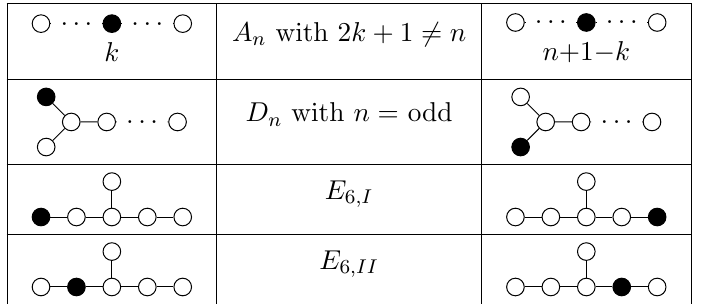
Table 1 . List of dual marked Dynkin diagrams for the dual parabolic subgroups leading to the Mukai (cid:13)ops of type A , D , E 6 ;I , and E 6 ;I . into a (cid:12)nite number of diagrams Y